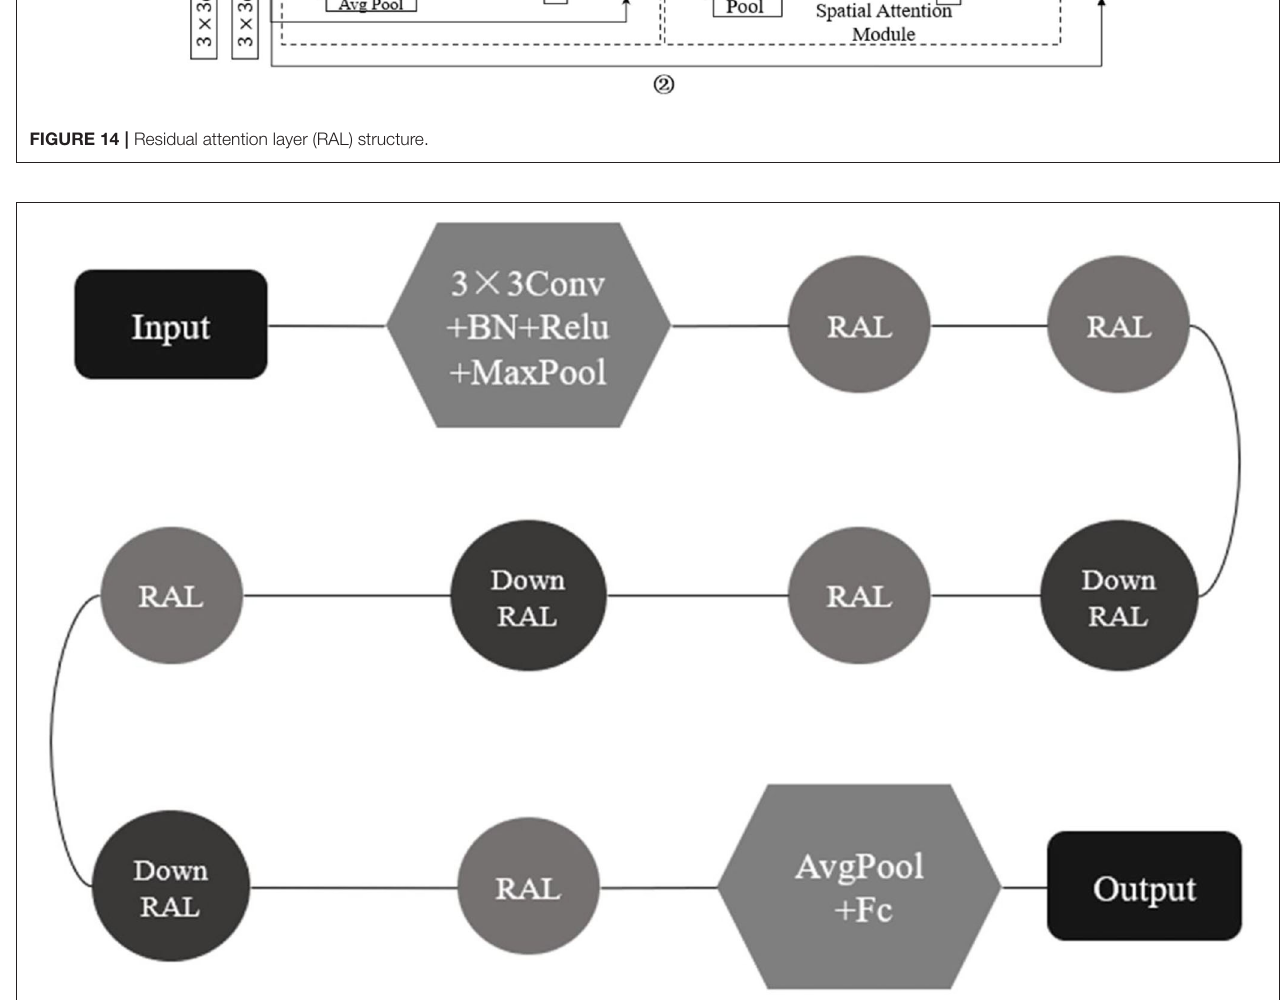
FIGURE 15 | Residual attention network (RANet)